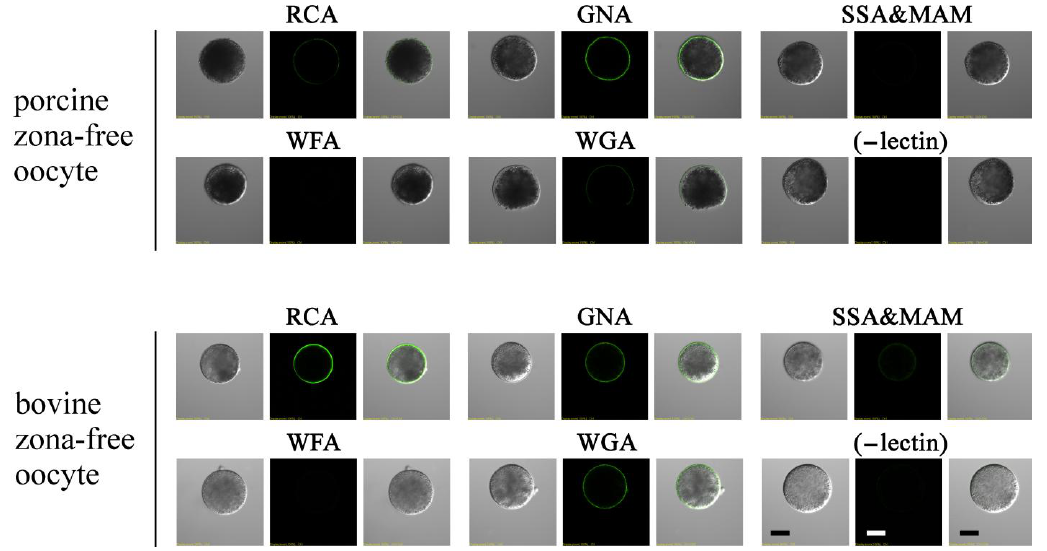
Figure 8. Localization of biotin-conjugated lectins in porcine and bovine zona-free oocytes. The oocytes were incubated separately with lectin (indicated above each panel) or without lectins (-lectin) followed by washing and incubation with UltraAvidin–Fluorescein. Left panels, phase-contrast; middle panels, fluorescence; right panels, phase-contrast and fluorescence images merged. Scale bar = 50